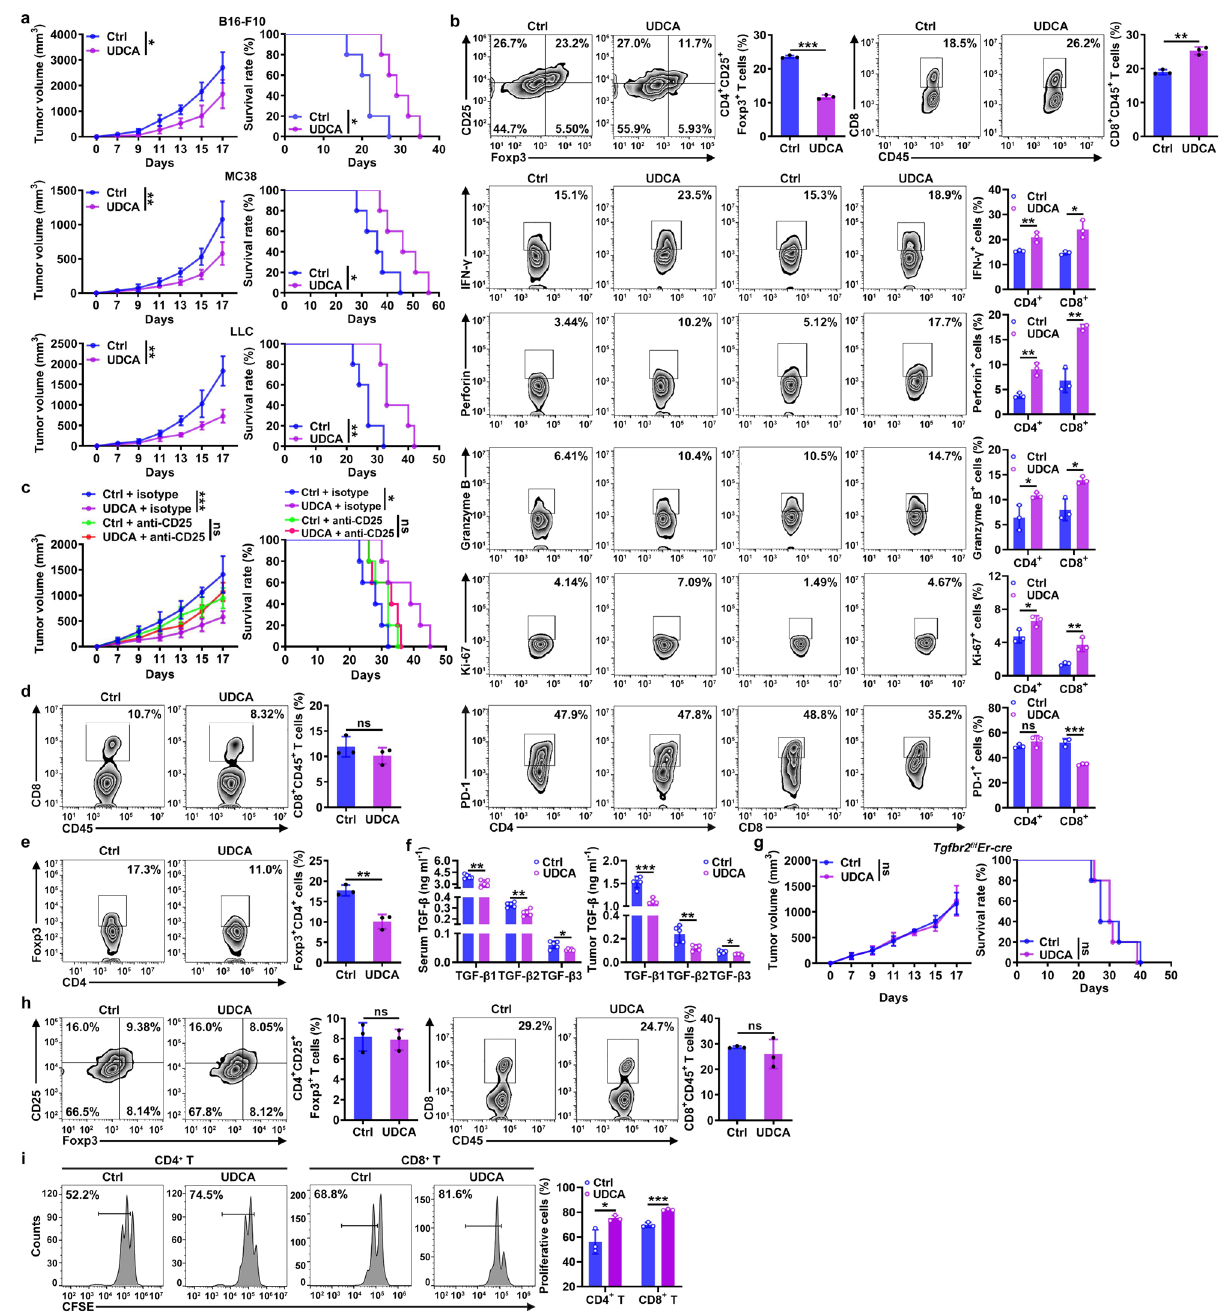
Fig. 1 UDCA inhibits tumor progression by modulating Treg cells. a , b Tumor sizes and mouse survival ( a ) and fl ow cytometric (FC) analysis of CD4 + CD25 + Foxp3 + Treg cells, total CD8 + T cells and the corresponding CD4 + and CD8 + T cell subsets among TILs on day 18 ( b ) in B16-F10, MC38 ( a ) and LLC ( a , b ) tumor-bearing mice that received intraperitoneal (i.p.) injection of 30 mg kg − 1 UDCA every 2 days. c – e Tumor sizes and mouse survival ( c ) and FC analysis of CD8 + CD45 + T cells and Foxp3 + CD4 + CD45 + T cells among TILs on day 18 ( d , e ) in LLC tumor-bearing mice treated with UDCA along with 100 μ g of anti-CD25 ( c , d ) or 40 μ g of anti-CD8-neutralizing antibodies (anti-CD8) ( e ) every 3 days. f ELISA of TGF- β 1, TGF- β 2, and TGF- β 3 in serum and tumor tissues of UDCA-treated LLC tumor-bearing mice on day 9. g , h Tumor sizes and mouse survival ( g ) and FC analysis of CD4 + CD25 + Foxp3 + Treg cells and CD8 + CD45 + T cells among TILs on day 18 ( h ) in LLC tumor-bearing Tgfbr2 f/f Er-cre mice treated with UDCA. i FC analysis of the proliferation of CFSE-labeled CD4 + or CD8 + T cells cocultured with CD4 + CD25 + Treg cells isolated from the spleens of UDCA-treated LLC tumor-bearing mice on day 18. Cells were cultured at a T cell:Treg cell ratio of 4:1 in anti-CD3 and anti-CD28-coated plates for 5 days. Representative results from three independent experiments are shown ( n = 5 in ( a , c , f , g ); n = 3 in ( b , d , e , h , i ). * P < 0.05; ** P < 0.01; *** P < 0.001; ns, not signi fi cant (unpaired two-tailed Student ’ s t test except for log-rank test for survival rate analysis; mean and s.d.). See Source Data fi le for the exact P -values.